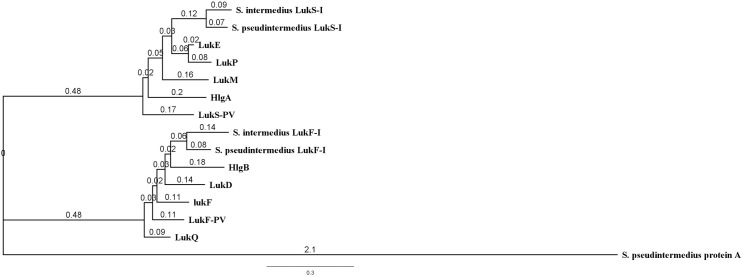
Phylogenetic tree based on amino acid sequences of mature leucocidins produced by S. aureus, S. intermedius and S. pseudintermedius.S. pseudintermedius LukS-I is closely related to S. intermedius LukS-I, S. aureus LukE and LukP. S. pseudintermedius LukF-I is closely related to S. intermedius LukF-I and S. aureus gamma hemolysin subunit B. S. pseudintermedius protein A was used as an outgroup.